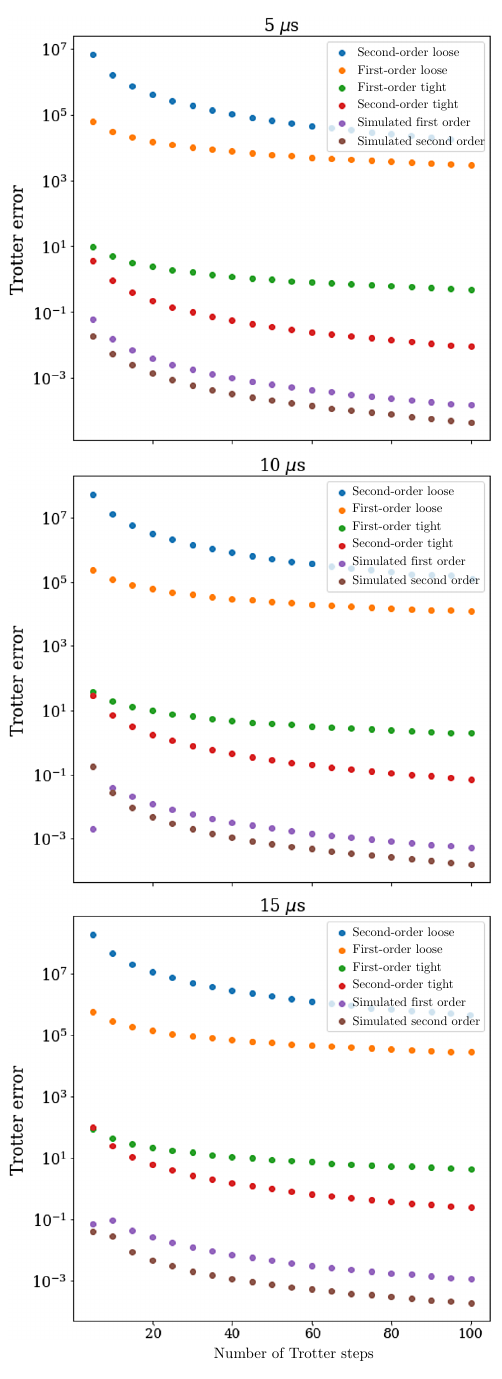
FIG. 6. The Trotter error in the 11-qubit system. The error bounds used are described in the main text. In all of these results, we use a magnitude ordering of Hamiltonian terms in the product formula; the terms with the largest coefficients are placed first in the Trotter